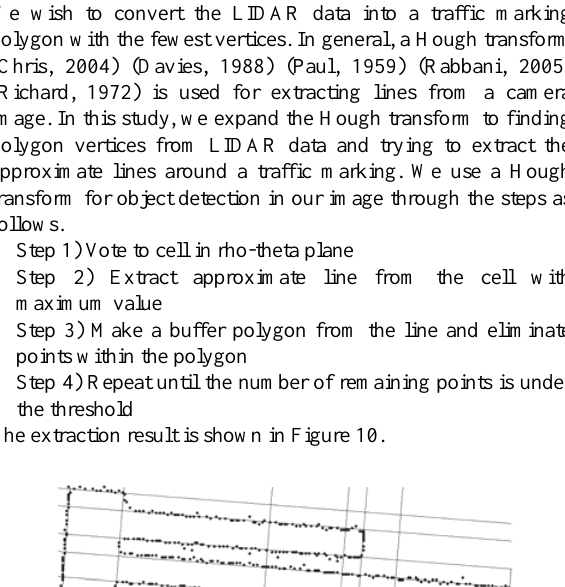
Figure 9. Points from polygon vertices